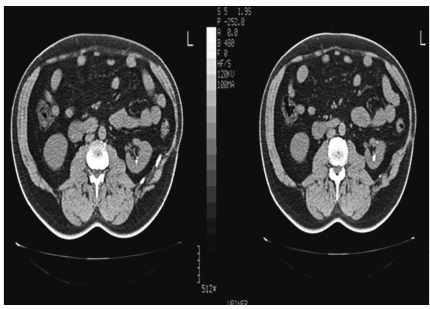
Figure 1: Preoperative CT imaging showing left kidney stone.